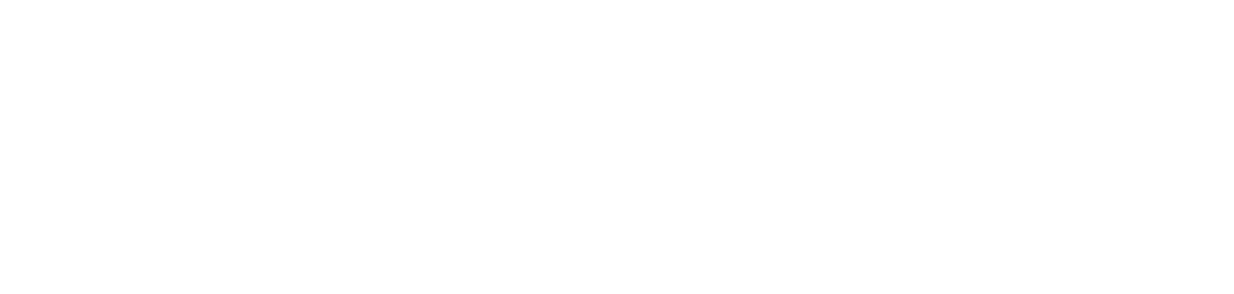
Table A.3 lists the G (cid:2) E values used to calculate the fl uxes available at https://www.ngdc.noaa.gov/stp/satellite/satdataser- vices.html. To convert those fl uxes to bow-tie fl uxes, they need to be fi rst converted into counting rates by multiplying them with the correct nominal G (cid:2) E from Table A.3, and then divided with the correct bow-tie G (cid:2) E values from Table A.1. In the case of integral fl uxes, the counting rates are summed (HEPAD counting rates can be summed because they are logically mutually exclusive) before dividing with appropriate bow-tie G values from Table A.2. Note that the integral channel P11 has been processed as a differential channel in the data fi les, which is why the nominal G (cid:2) E value is given in differential units in Table A.3. It is important to remember that the range of spectral indices used to calculate the bow-tie values is valid for SEPs, but not GCRs; therefore, background subtraction should always be performed when using the bow-tie fl uxes.